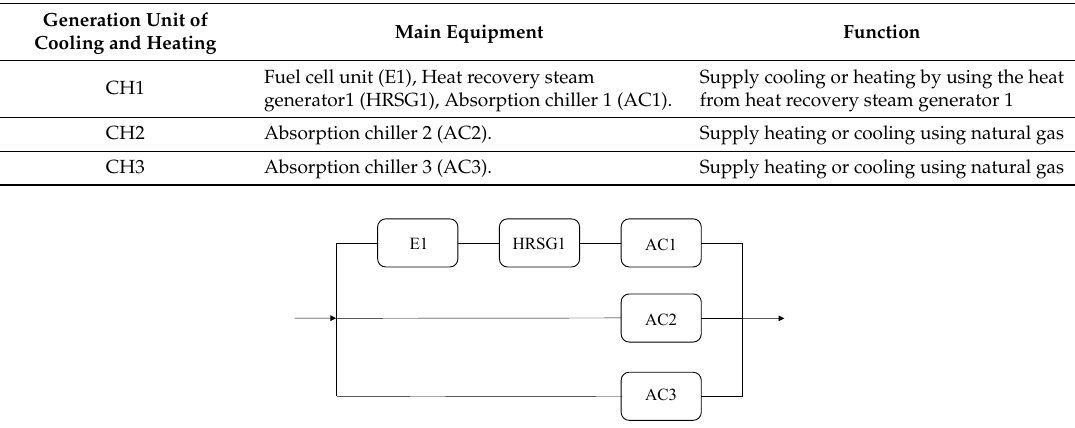
Figure 6. The reliability block diagram of the space cooling and heating subsystem of the CCHP system.